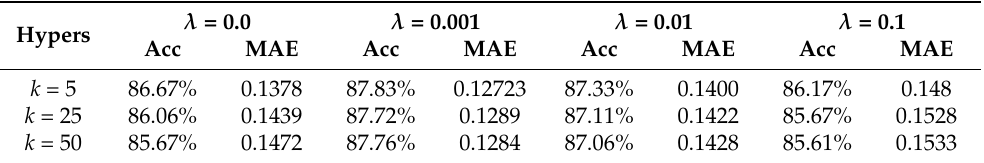
Table 3. The mean Acc and MAE of VISOR-NET under different hyper parameters with the FHVI dataset.